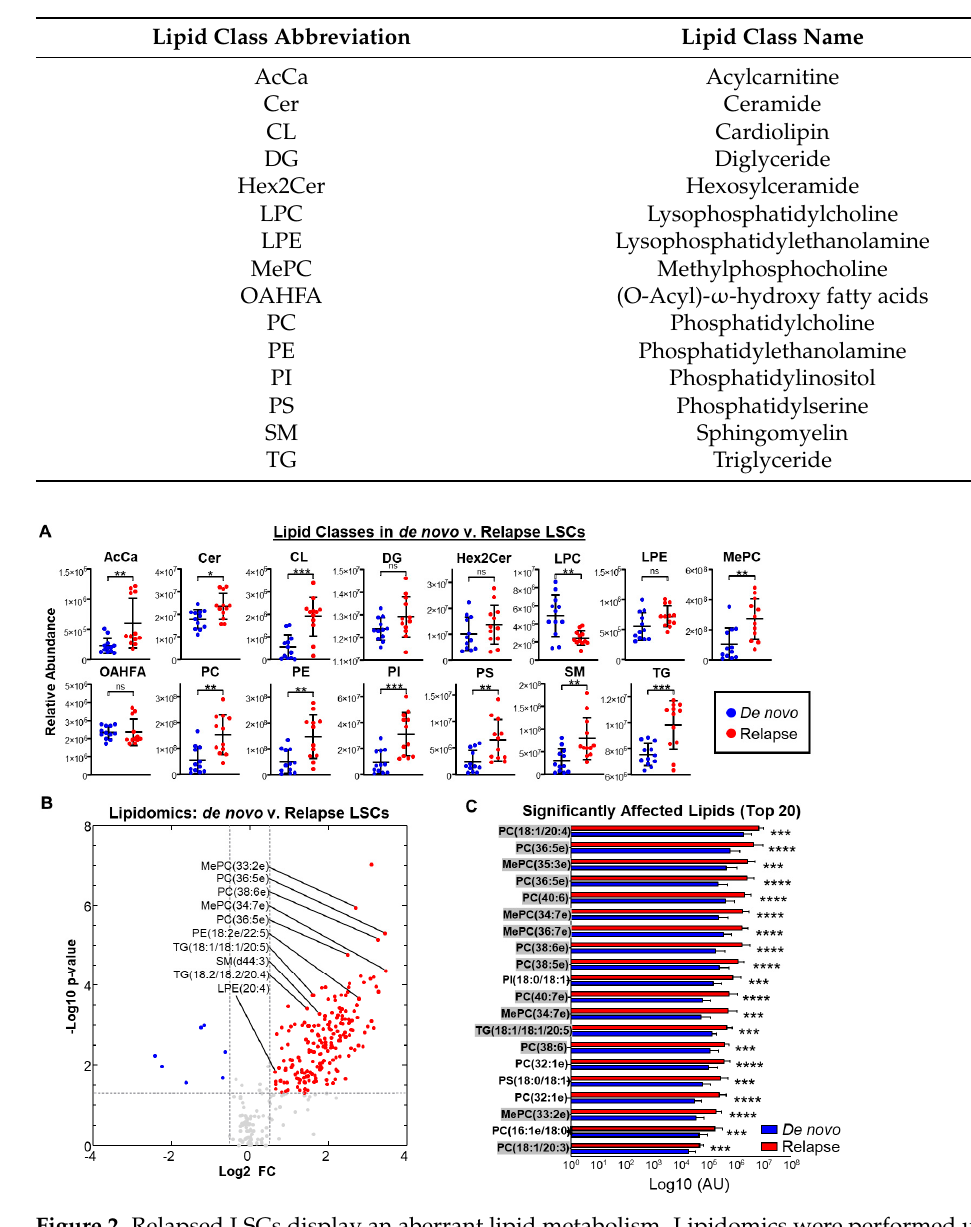
Table 1. Lipid class abbreviations.